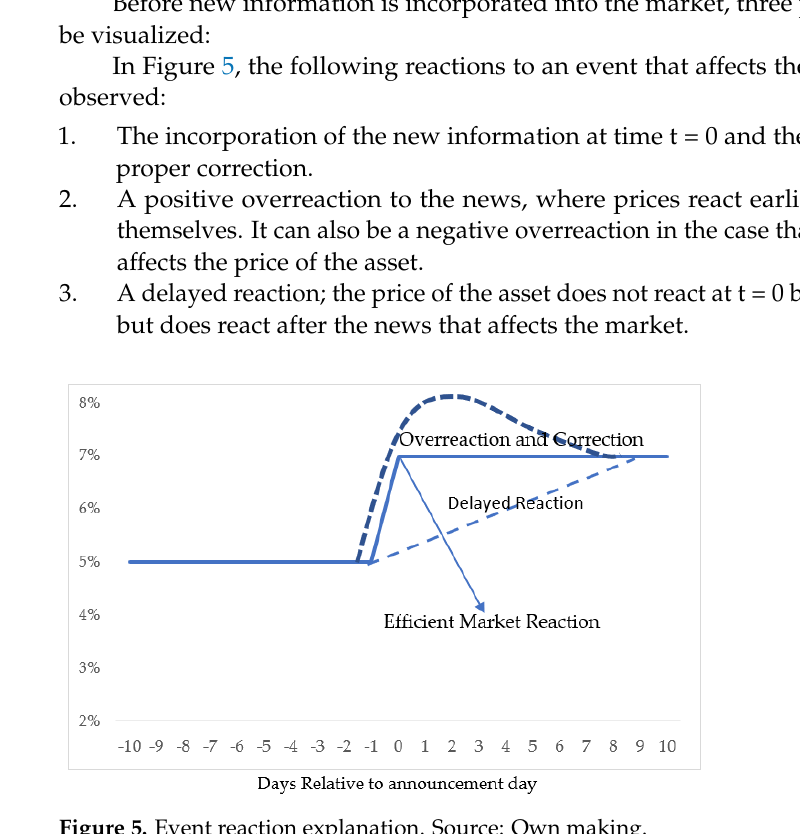
Table 3. Statistical data from the return series used in this study.